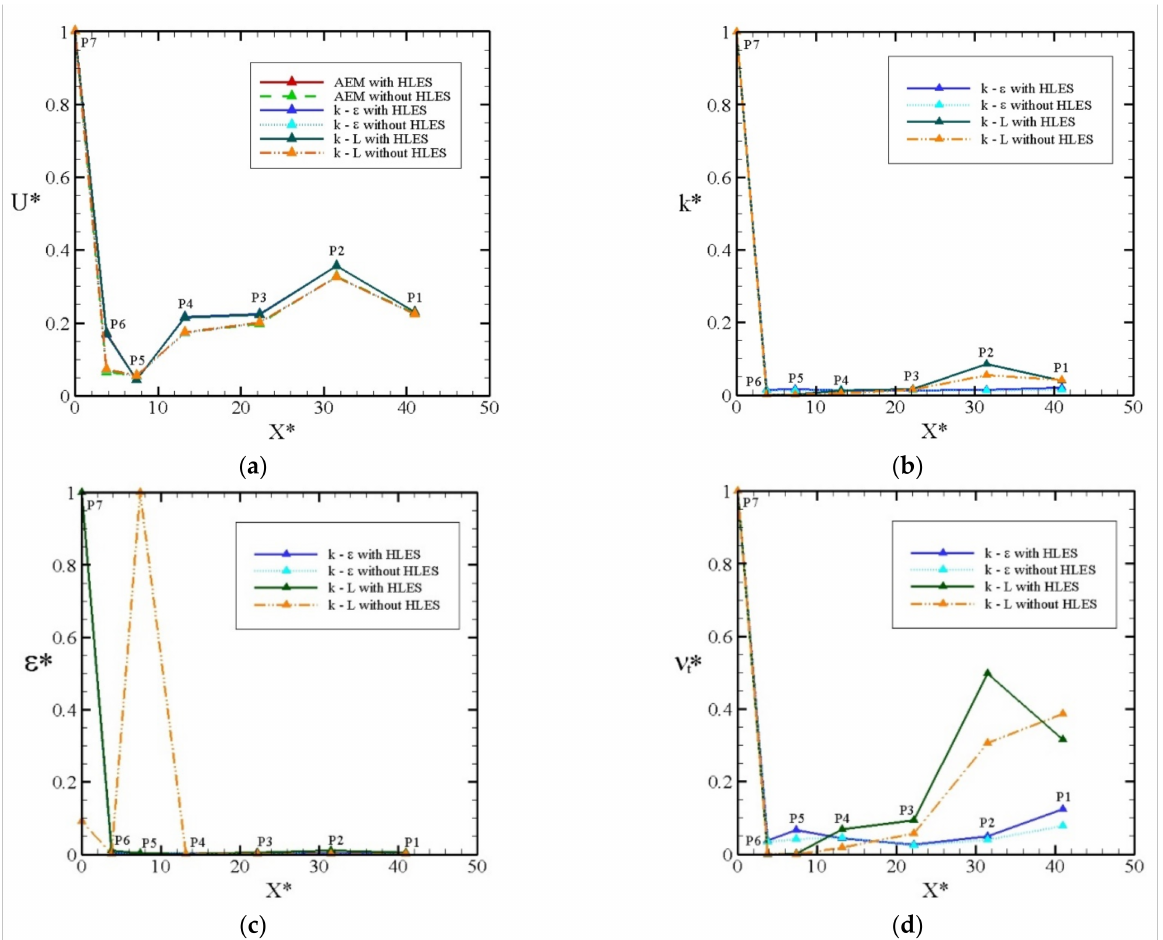
Figure 12. Evolution from P7 to P1 of ( a ) U ∗ ; ( b ) k ∗ ; ( c ) ε ∗ ; ( d ) ν ∗